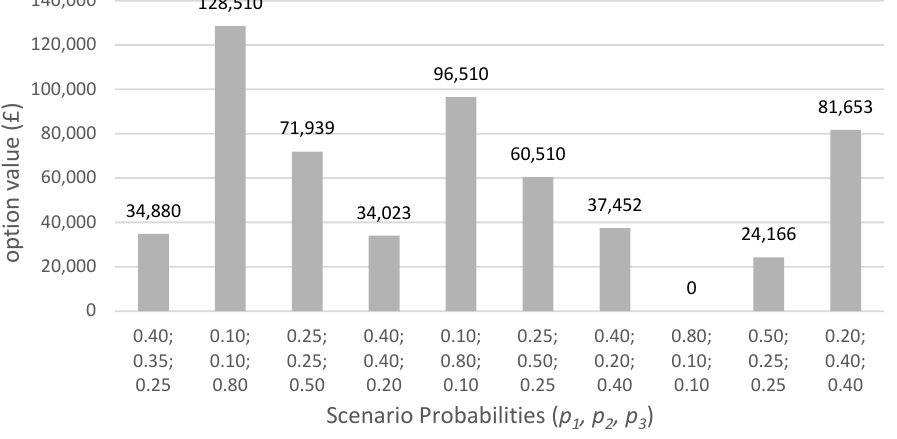
Figure 14. Option Value of Smart Charging of EV as a function of scenario probabilities, using BIF.